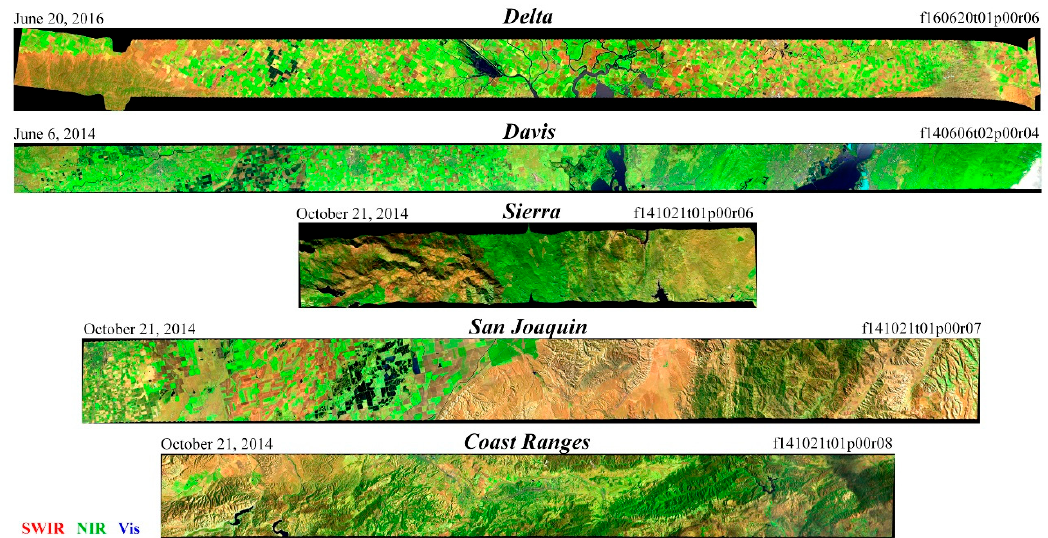
Figure 2. False color composite images of the five AVIRIS flight lines used in this study. A wide range of agriculture in the Great Central Valley of California is sampled in both summer and fall. Bare rock substrates are present in the Sierra and Coast Ranges. Non-photosynthetic vegetation (NPV) is present in both agricultural and natural land cover regimes. Cloud contamination near the ends of the Delta, Davis, and Coast Ranges lines was excluded from the remainder of the analysis. Wetlands are sampled in the Delta line and the San Joaquin line. Spectrally complex salt ponds are present in the South Bay portion of the Davis line. Sun glint is present in some water bodies.